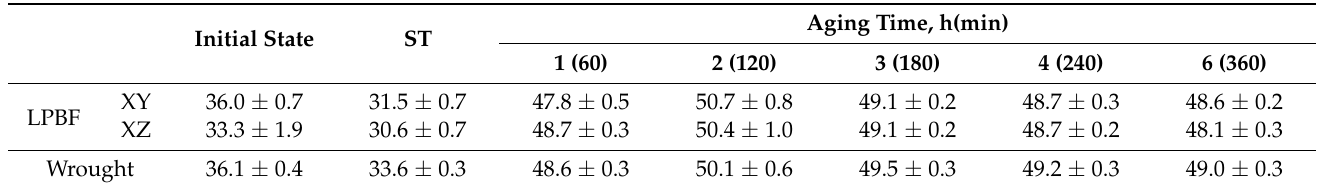
Table 2. Hardness (HRC) of the LPBF and wrought alloys as a function of processing state.